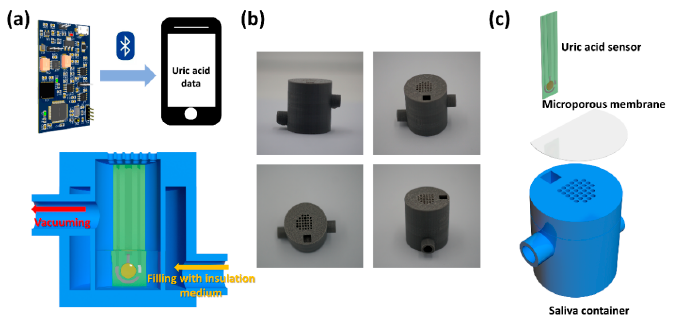
Figure 1. ( a ) Schematic diagram showing the structure and the application scenarios of the PSSS. ( b ) Photographs of saliva collection containers from different angles. ( c ) Assembly of the saliva container, microporous membrane, and the UAS.